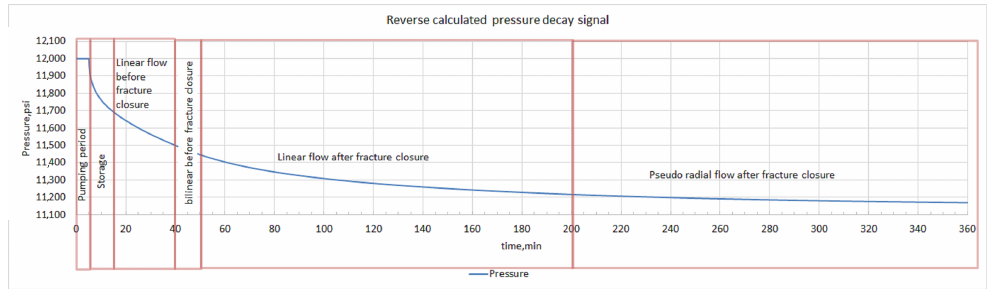
Figure 17. Synthetic reverse-calculated pressure decay signal.